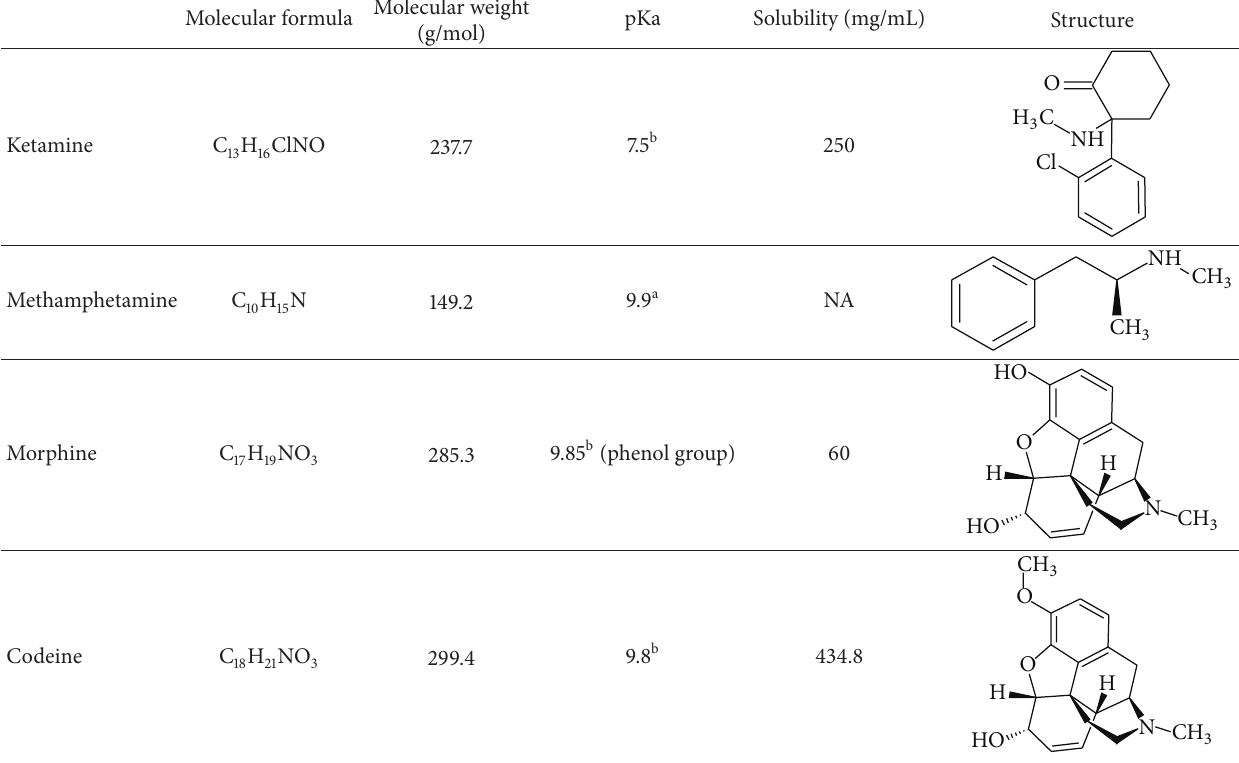
Table 1: Physicochemical properties of ketamine, methamphetamine, morphine, and codeine. Molecular weight Molecular formula